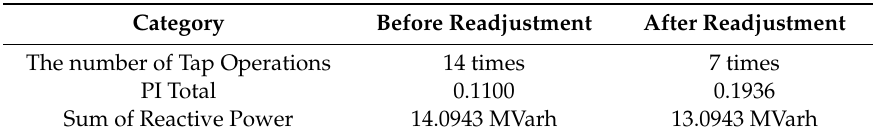
Table 8. Comparison of the number of tap operations, PI total, sum of reactive power with / without proposed method of case 1 for CVR.